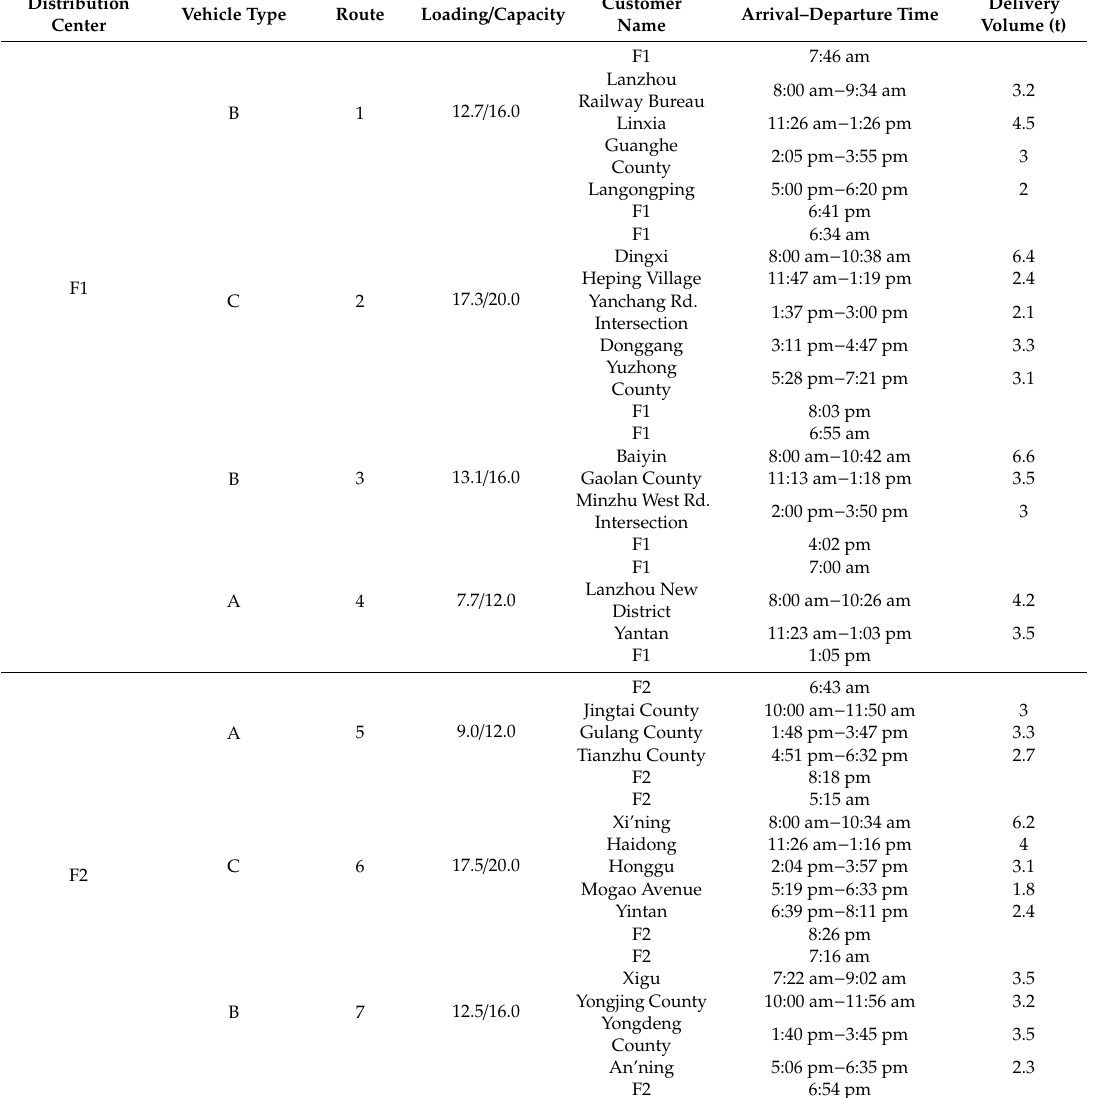
Table 6. Hazardous materials optimal transportation plan based on traditional method (plan B). Distribution